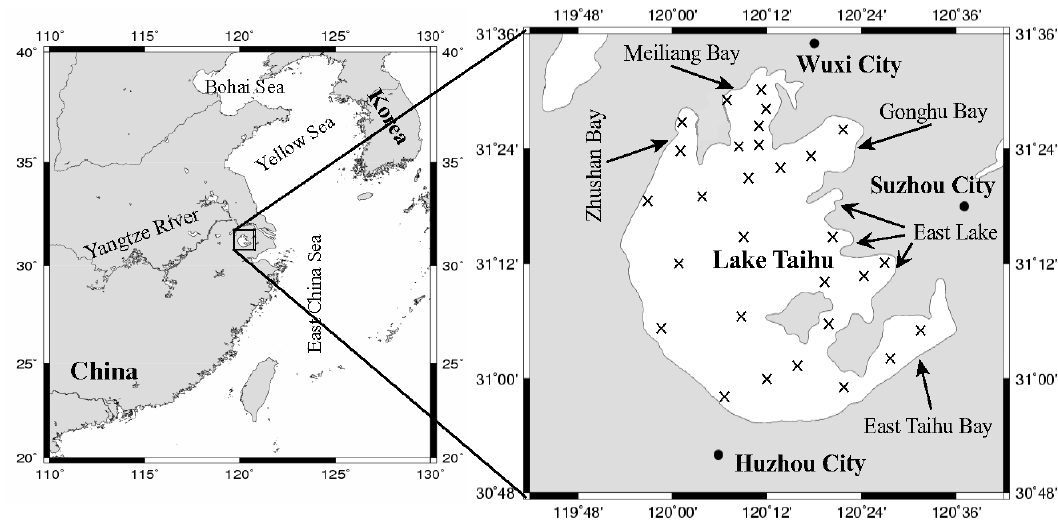
Figure 1. Maps of China’s inland Lake Taihu. Locations of the in situ TSM measurements. Between 2012 and 2016 are marked as “×” in Lake Taihu.